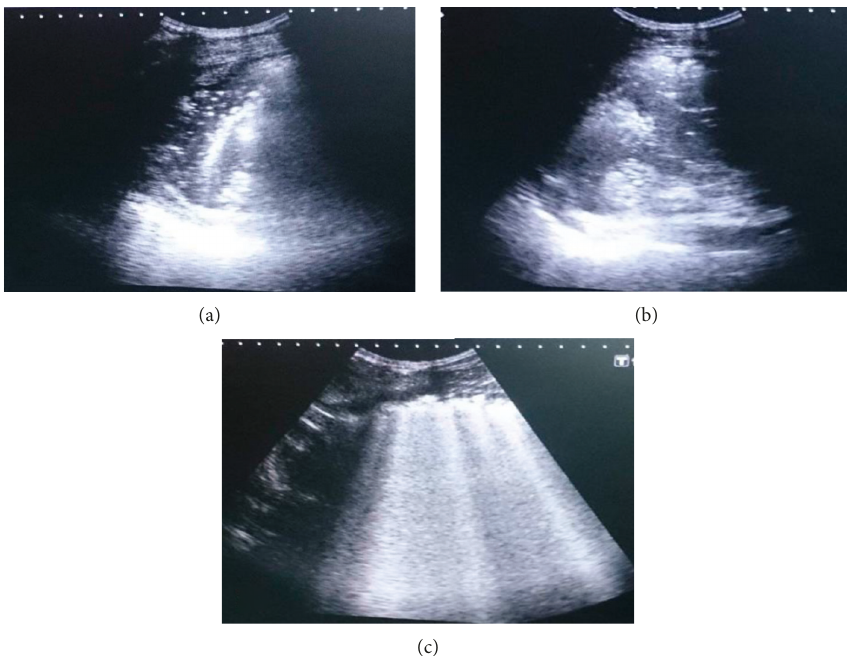
Figure 2: (a) Hypoechoic lesions in examined area filling all the examined area (score 2); (b) hypoechoic lesions in examined area not filling all the examined area (score 1); (c) more than 2 B-lines that were filling all the examined area (score 2).